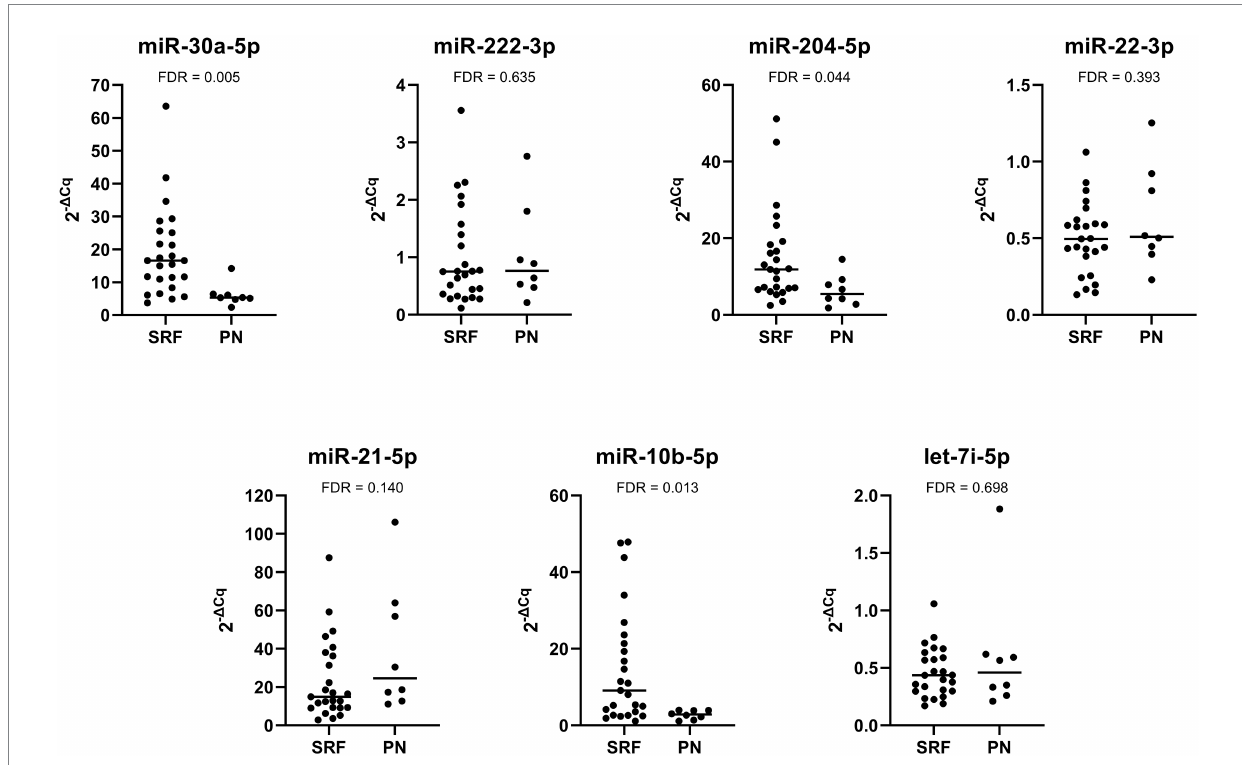
FIGURE 4 Comparison of relative expression of selected miRNAs between Fabry patients with stable renal function (SRF) and progressive nephropathy (PN).